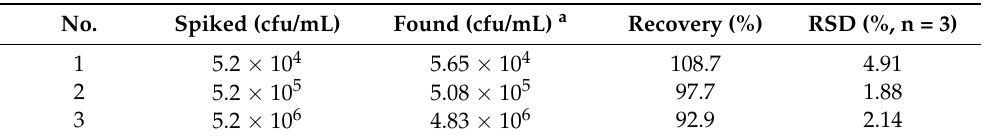
Table 3. Recovery and relative standard deviation (RSD) of S. Typhimurium in artificially contami- nated